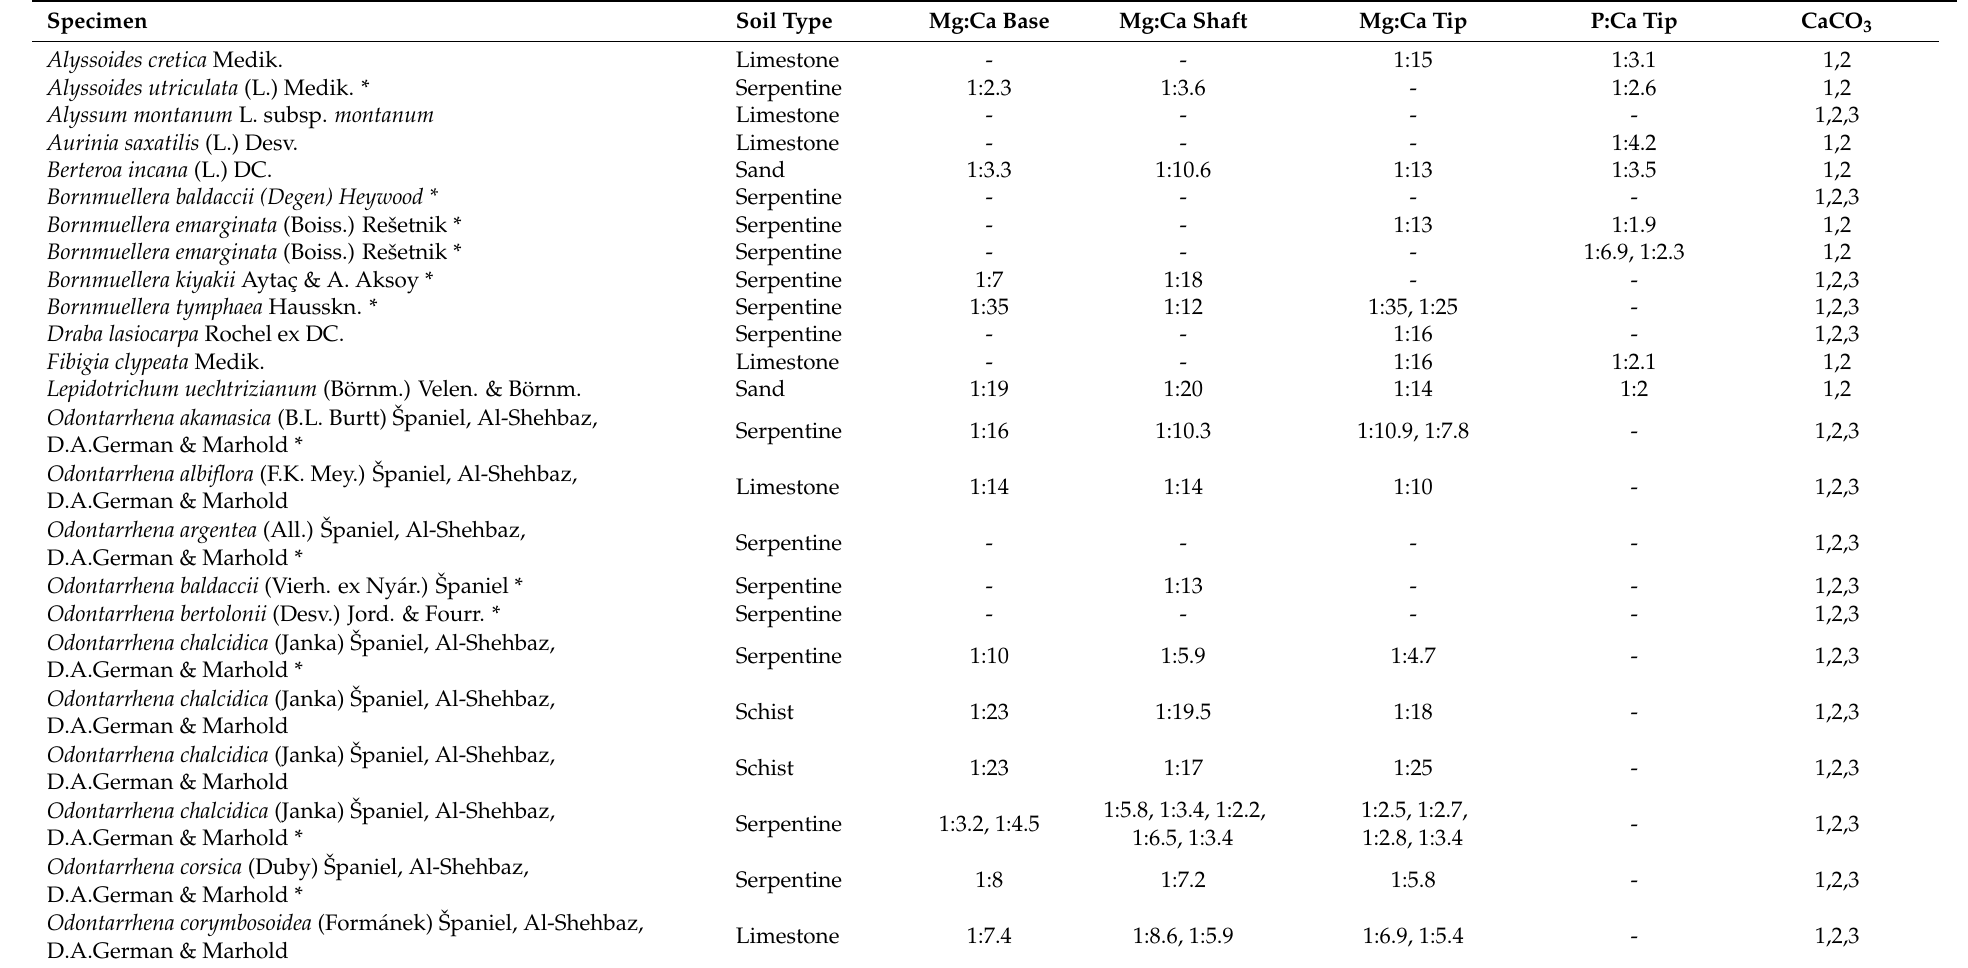
Table 1. List of examined taxa and accessions with soil type and elemental distribution of analyzed spots denoting the presence of Mg and P expressed as a ratio, and CaCO 3 expressed as present or